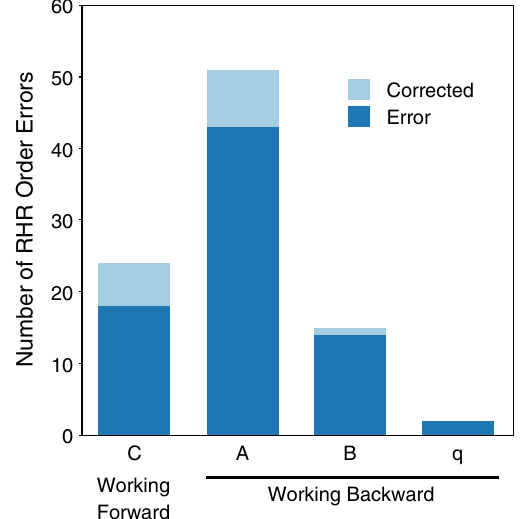
FIG. 10. The number of RHR: Order errors by the type of reasoning required. Backward problems are separated by the type of answer required, i.e., A means that the first vector in the cross product was required, B means the second vector was required, and q means that all vectors were provided and the sign of the charge was required.